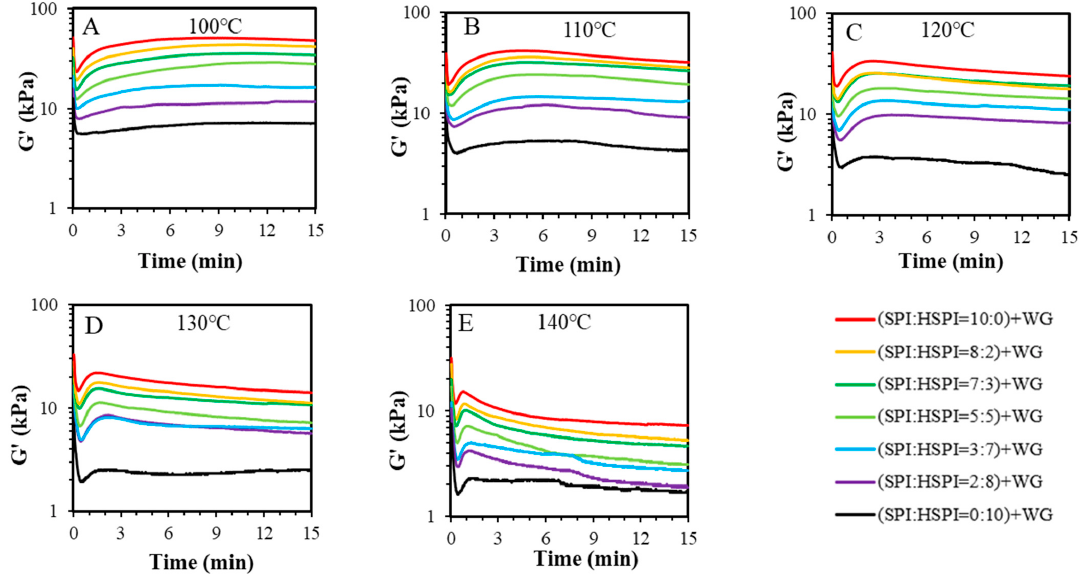
Figure 3. Time sweep measurements (80% strain, 10 Hz frequency) for SPI: HSPI = 10:0 + WG, SPI: HSPI = 8:2 + WG, SPI: HSPI = 7:3 + WG, SPI: HSPI = 5:5 + WG, SPI: HSPI = 3:7 + WG, SPI: HSPI = 2:8 + WG, and SPI: HSPI = 0:10 + WG at various temperatures: ( A ) 100 °C, ( B ) 110 °C, ( C ) 120 °C, ( D ) 130 °C, and ( E ) 140